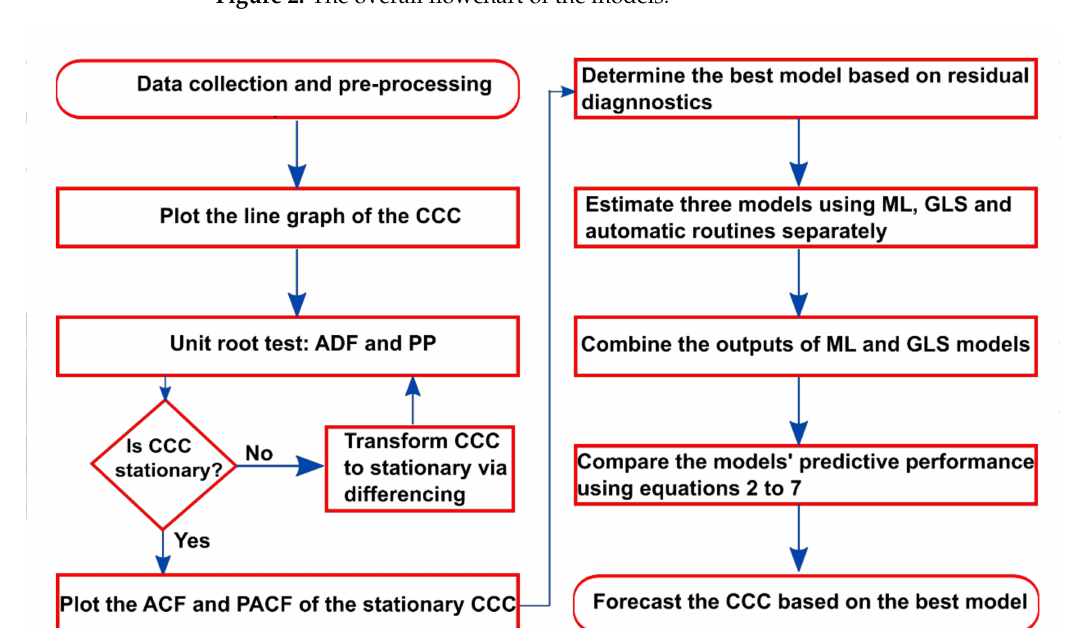
Figure 3. Algorithm for developing the ARIMA